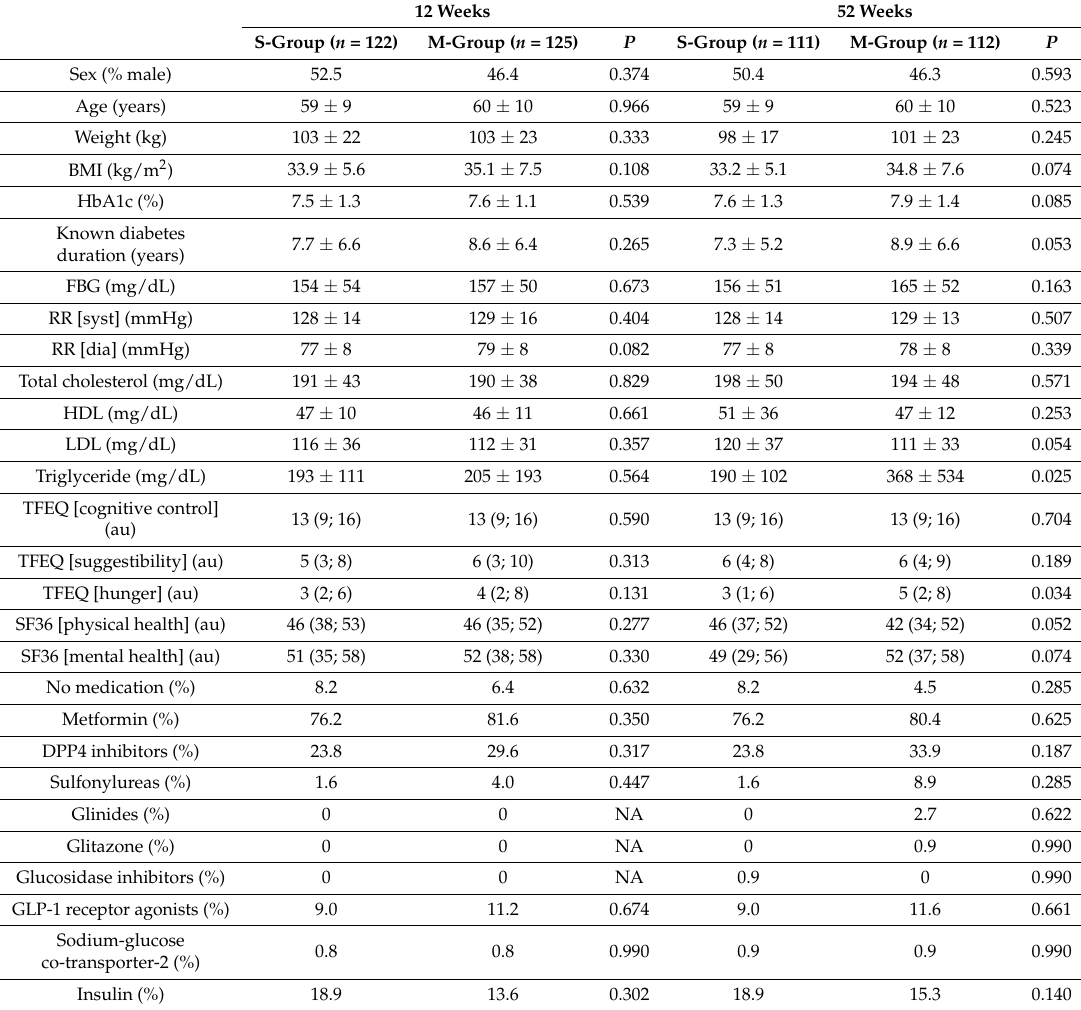
Shown are means ± standard deviations, median (1st; 3rd quartiles) or percentages. Differences after 12 and 52 weeks between groups were analyzed using multivariable regression models adjusting for baseline values; au, arbitrary units; FBG, fasting blood glucose; BMI, body mass index; DBP, diastolic blood pressure; HDL, high-density-lipoprotein; LDL, low-density-lipoprotein; NA, not applicable; SBP, systolic blood pressure; SF36, short form-36; TFEQ, three-factor eating questionnaire; DDP4, dipeptidyl peptidase 4; GLP-1, glucagon-like